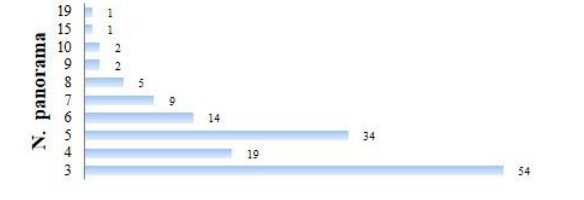
Figure 11. Number of panoramas per project.